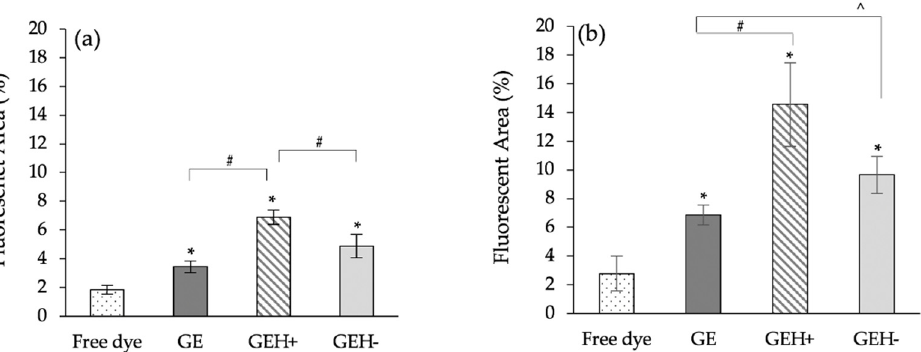
Figure 8. Quantification of posterior eye segment with red fluorescence: ( a ) eye drops, and ( b ) SCI treatment. Mean ± SD, n = 9. (* p < 0.05 compared with free dye, ^ p < 0.05 compared with GE, # p < 0.05 compared with GEH+).